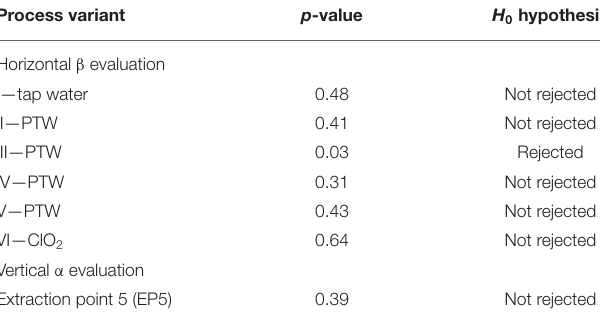
TABLE 7 | Statistical evaluation of storage day 1.